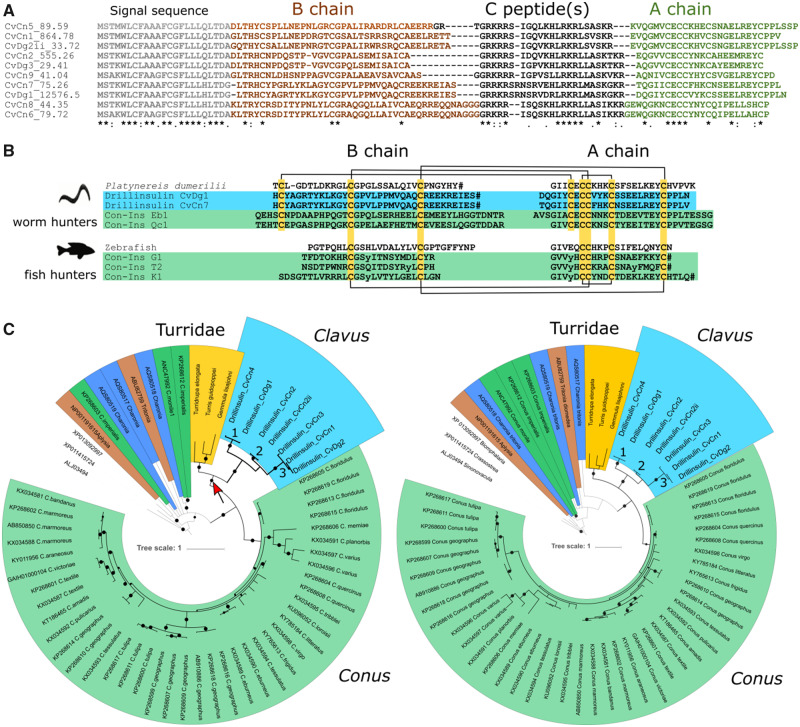
—Clavus insulins. (A) Comparative sequence alignment of Clavus insulins and their expression values (tpm) showing conserved signal peptides and variable A and B chain regions. Amino acid conservations are denoted by an asterisk (*). Full stops (.) and colons (:) represent a low and high degree of similarity, respectively. (B) Alignment of the B and A chains of two representative Clavus insulins (purple) with insulins sequenced from the marine worm Platynereis dumerilii and venom insulins sequenced from worm-hunting cone snails (pink). An alignment of the B and A chains of zebrafish insulin with venom insulins from fish-hunting cone snails is shown for comparison. Cysteines are shown in yellow and disulfide frameworks are depicted as connecting lines. Amino acid code: O = hydroxyproline; y = y-carboxylated glutamate; #, C-terminal amidation. (C) Bayesian phylogenetic trees of the gastropod insulins. Left: based on the analysis of entire precursor; right: based on the mature peptide region. Diameter of black circles proportional to support (as posterior probability 0.50–1) of corresponding nodes. Thickened lines denote segment of the tree corresponding to conoidean venom insulins. Colored segments as brown: heterobranchia; dark-blue: Charonia tritonis (Tonnoidea); dark green: Conus nerve ring; yellow: Turridae; blue: Clavus spp.; and light-green: Conus venom gland.